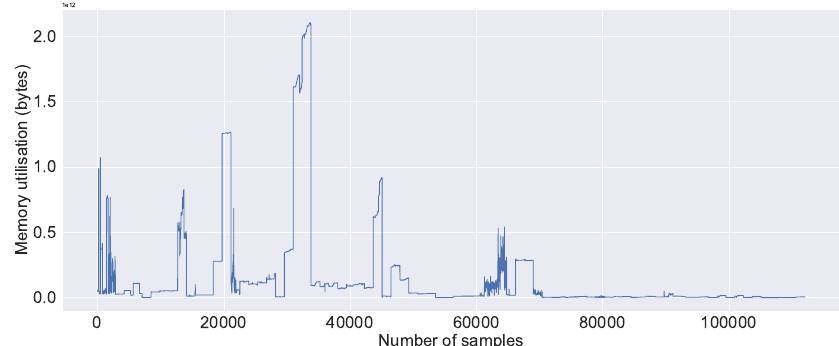
Figure 1. Memory utilisation data distribution